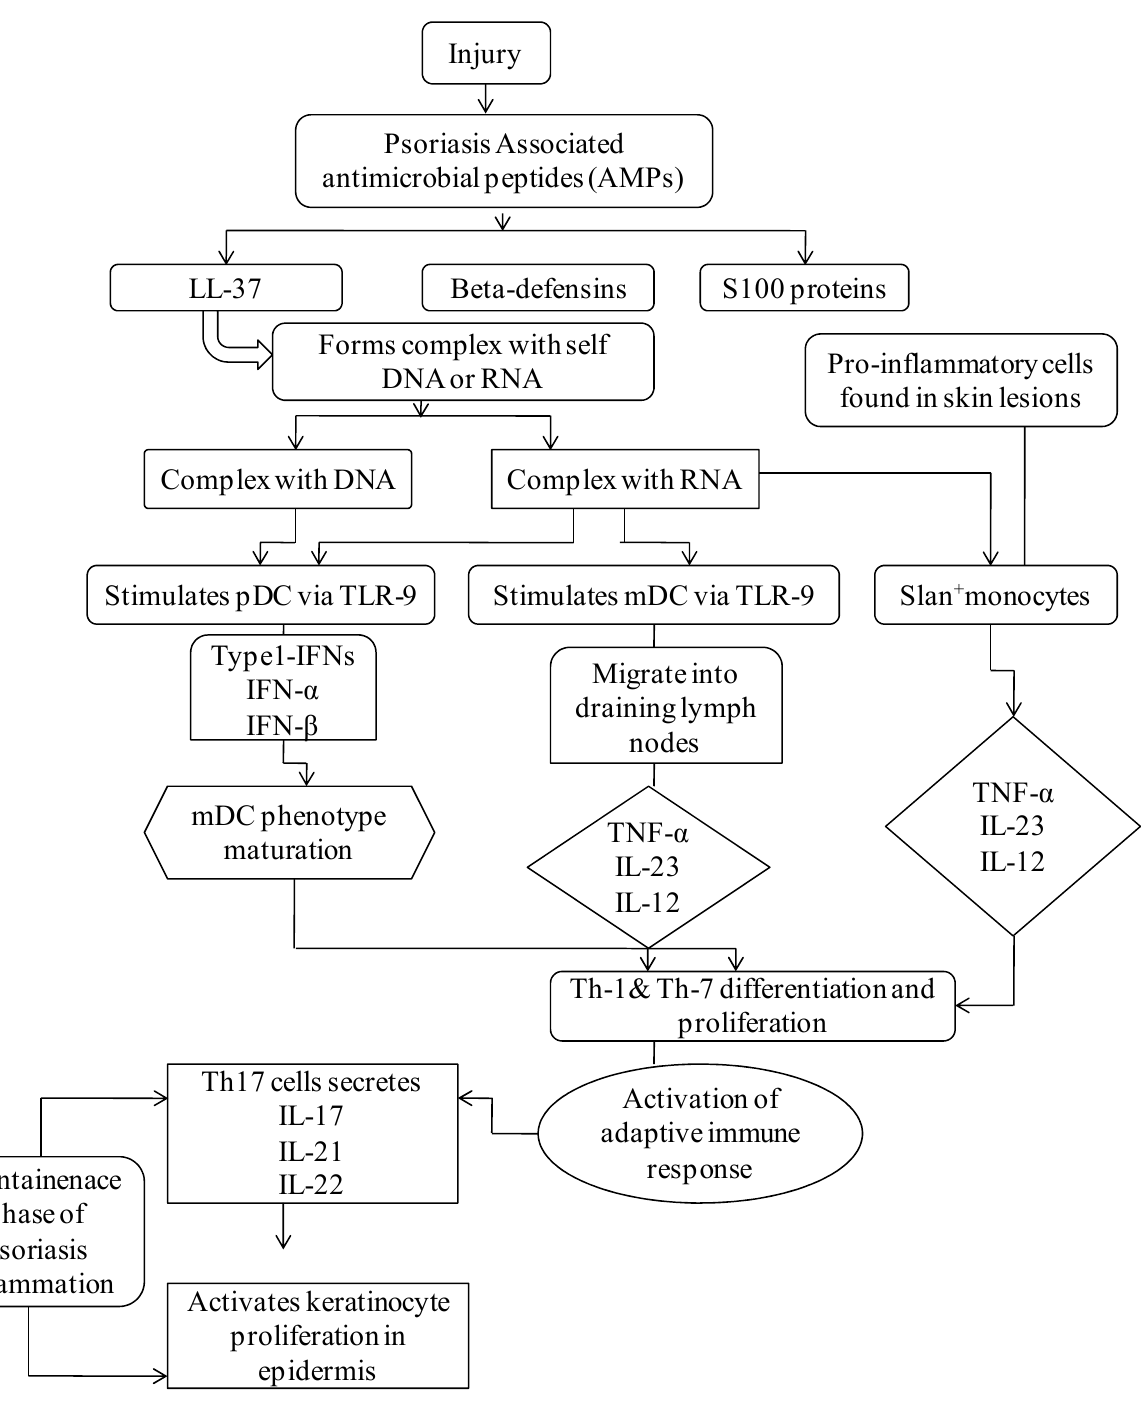
Figure 1. Pathogenesis of psoriasis.